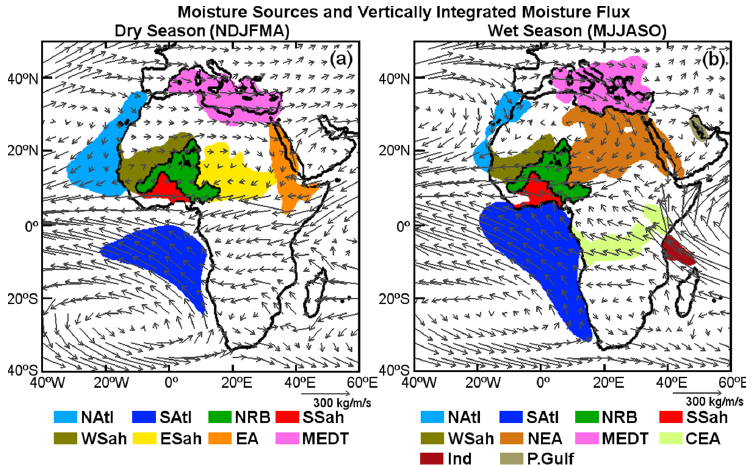
Figure 5. Schematic representation of moisture sources for the NRB (colour shaded areas) and average vertically integrated moisture flux (VIMF) (arrows) from ERA-Interim, for the period 1980–2014 during the dry ( a ) and wet ( b ) seasons.